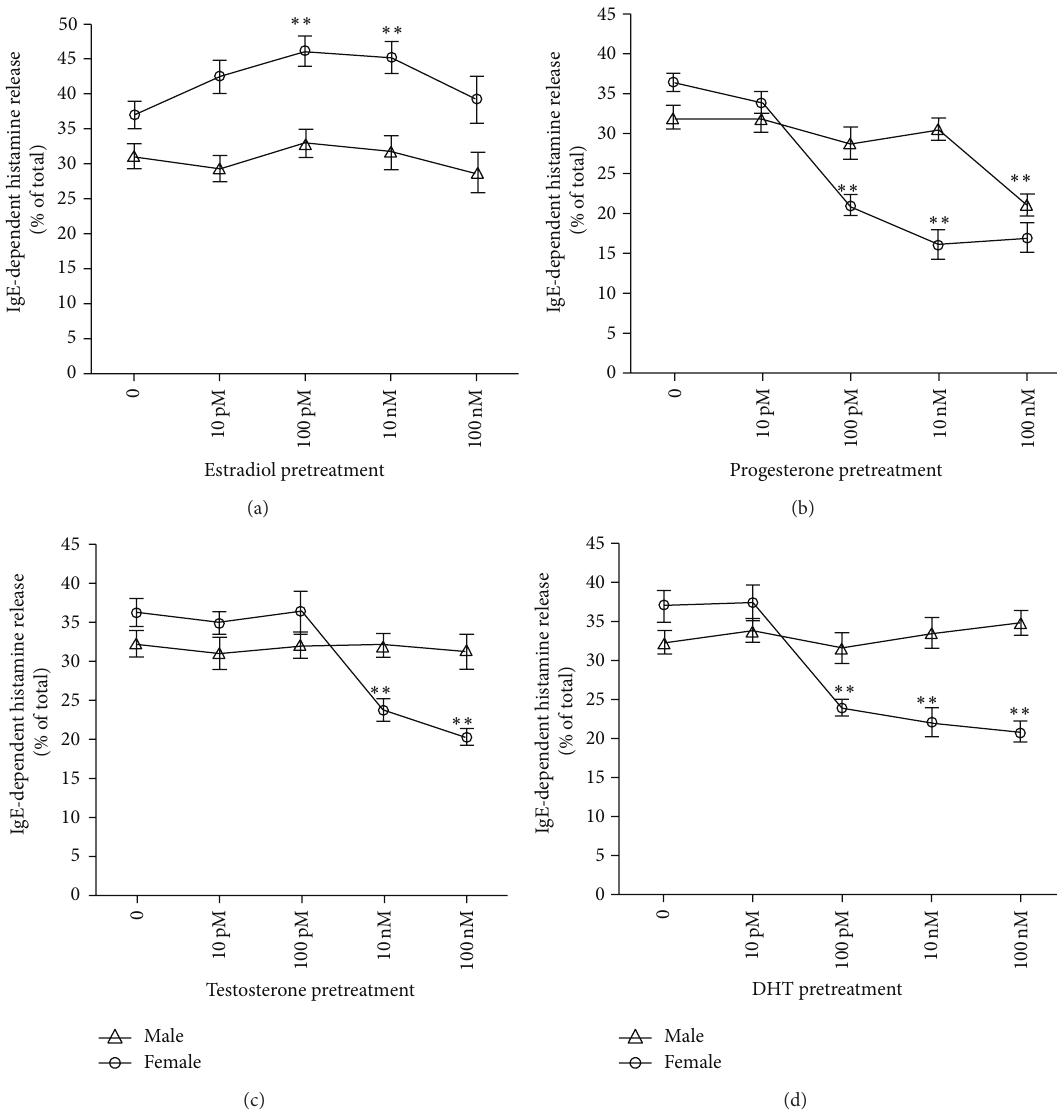
Figure 3: Differential effect of sex steroids on histamine release by PMCs from male and female rats, immunologically stimulated by the system IgE-DNP. PMCs were pretreated with each hormone at the indicated concentrations and sensitized at the same time with antidinitrophenyl (DNP) IgE (10 𝜇 g/mL). PMCs were then stimulated with DNP-HSA (100ng/mL) for 30 min in the presence of the corresponding hormone. The release of histamine was measured. ∗ 𝑃 < 0.05 IgE anti-DNP + DNP-HAS plus hormone versus IgE anti-DNP + DNP-HSA